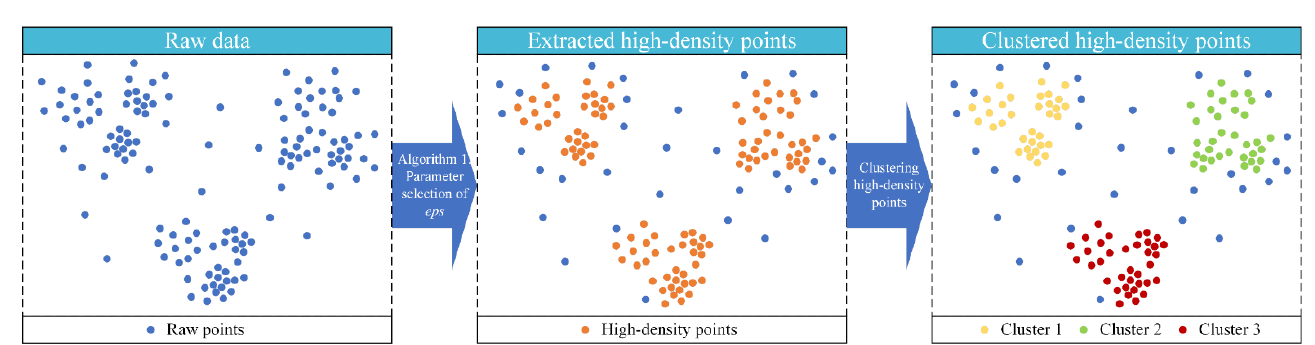
Figure 5. Processing flow of high-density points. The parameter eps is selected by Algorithm 1 and then high-density points can be extracted and clustered.